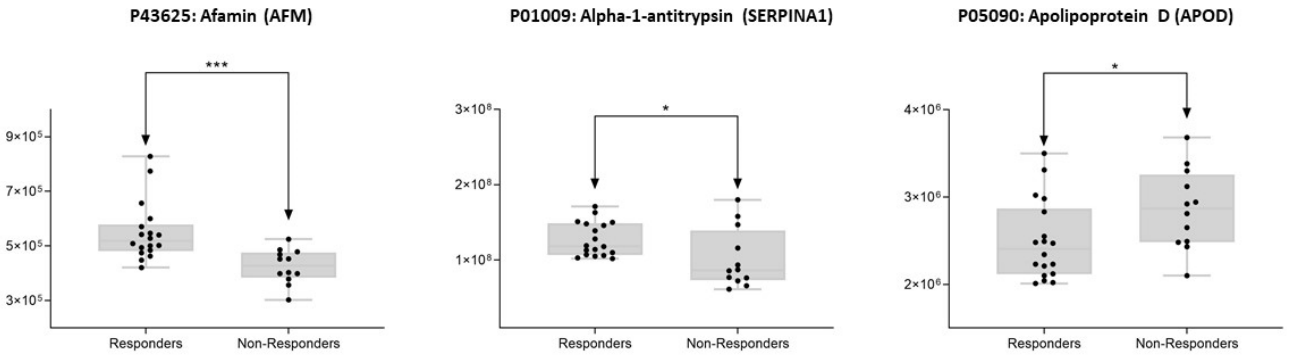
Figure 5. Box plots depicting the three-serum protein AFM, SERPINA1, and APOD levels in each of the study groups (responders and non-responders to NAC). Each data point represents the median value from a single sample. The line inside the box represents the median of all obtained values. The box’s upper and lower limits represent the first and third quartiles, respectively. Whiskers represent the lowest and highest values within 1.5 times the interquartile range. Outliers are any data points that are not included between the whiskers. * p < 0.05; *** p < 0.001.